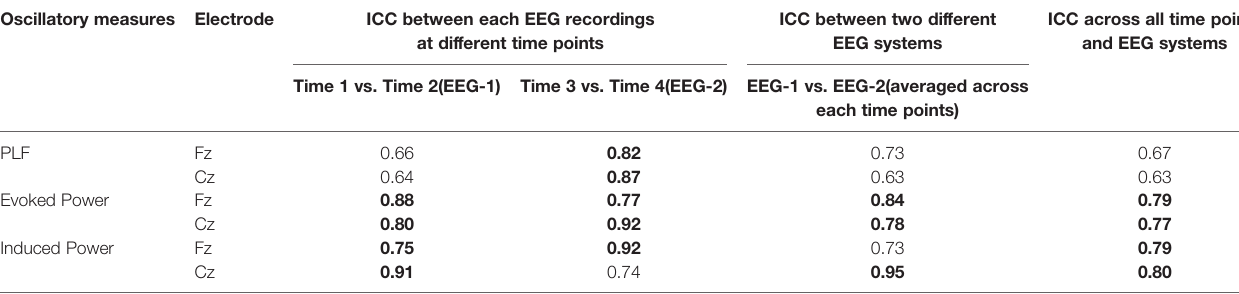
at different time points